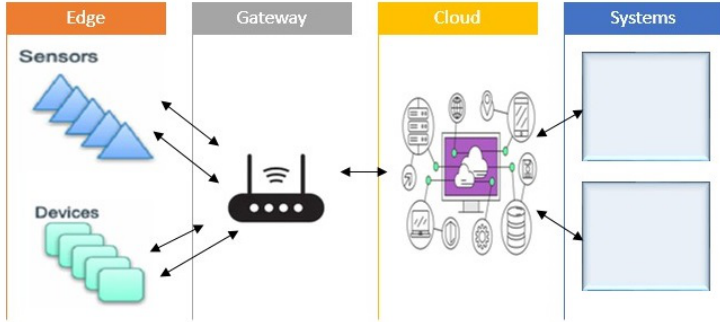
Figure 3. IoT gateway